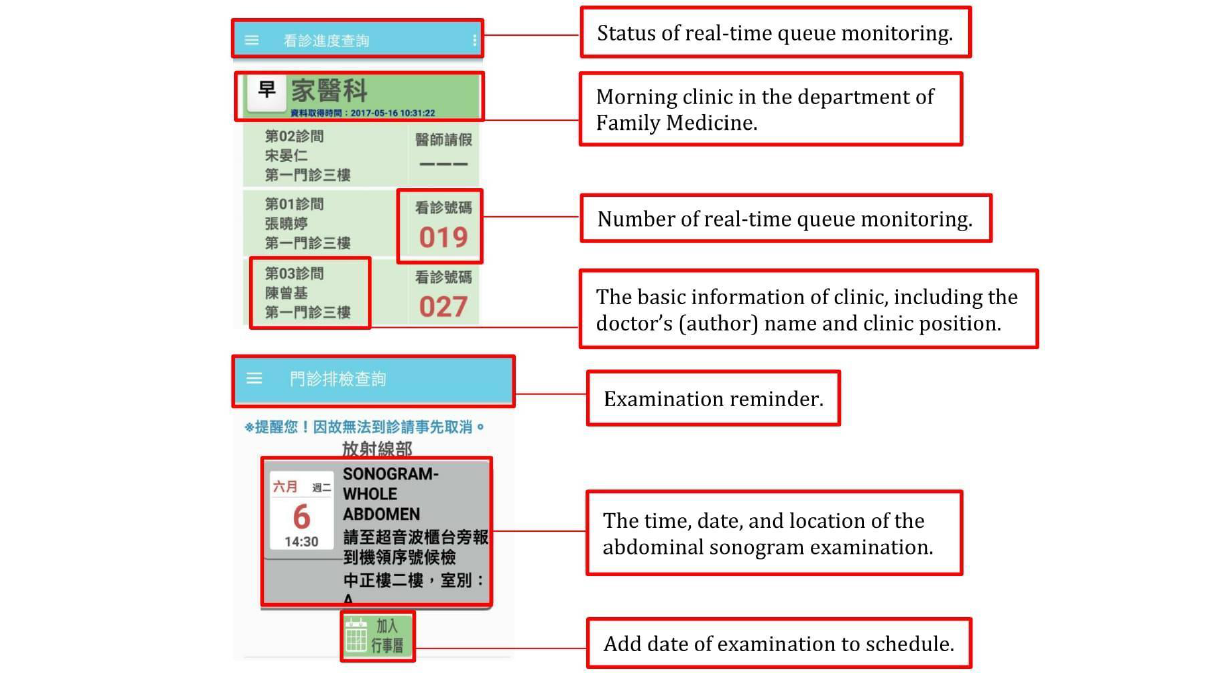
Figure 1. Screenshot of the real-time queue monitoring and examination reminder features of an app provided by Taipei Veterans General